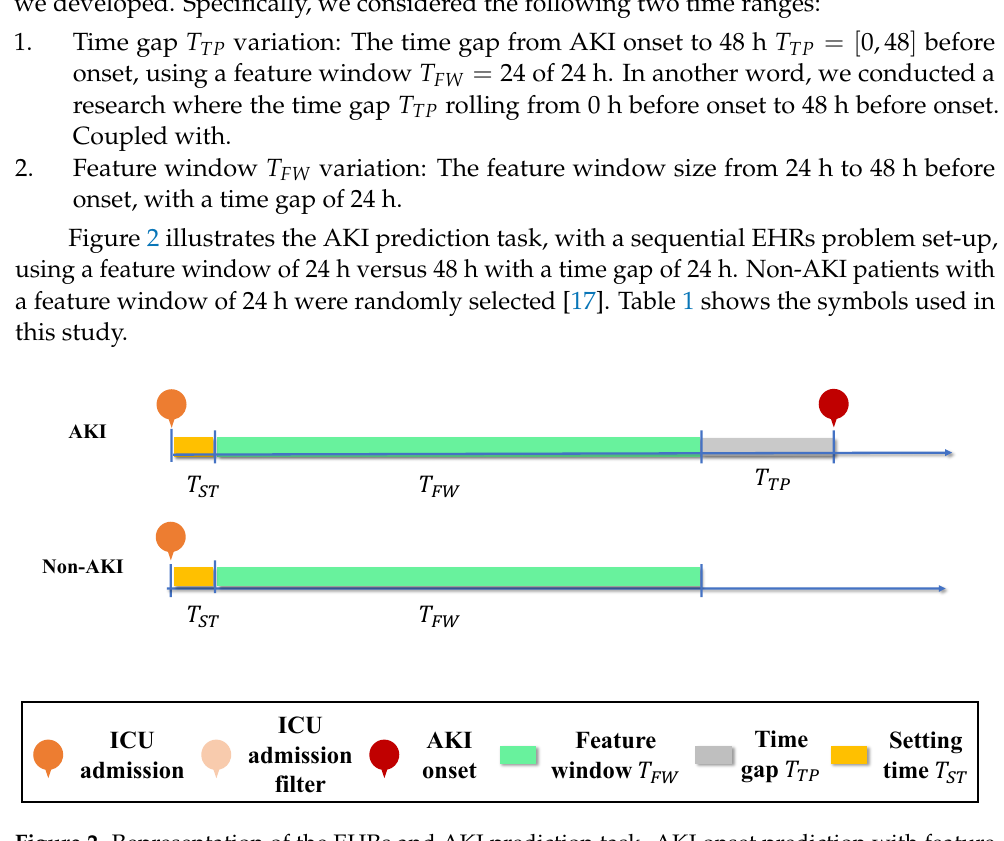
Figure 2. Representation of the EHRs and AKI prediction task. AKI onset prediction with feature window variation of 24 h and 48 h with a time gap of 24 h is illustrated. Non-AKI patients with a feature window of 24 h were randomly